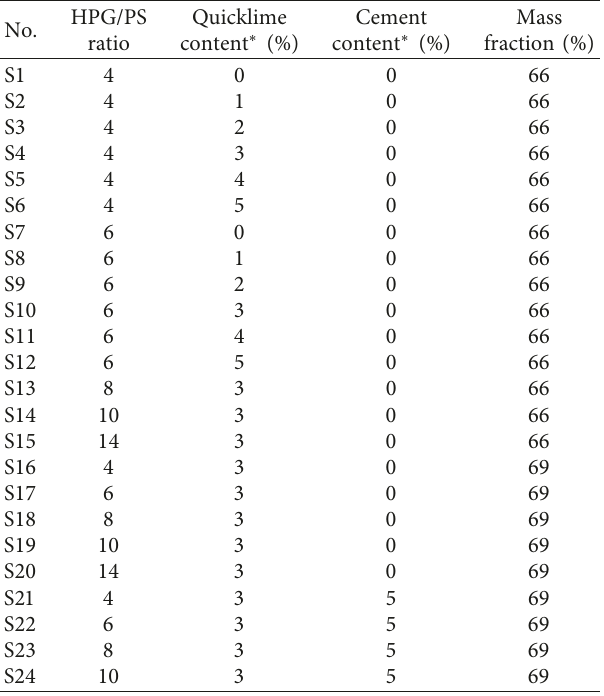
Figure 3: Auxiliary tests process of CPB-based HPG-PS. (a) Mass fraction of 66%; (b) mass fraction of 69%; (c) backfill body with the HPG/ PS ratio of 6. Table 2: Mix proportions of